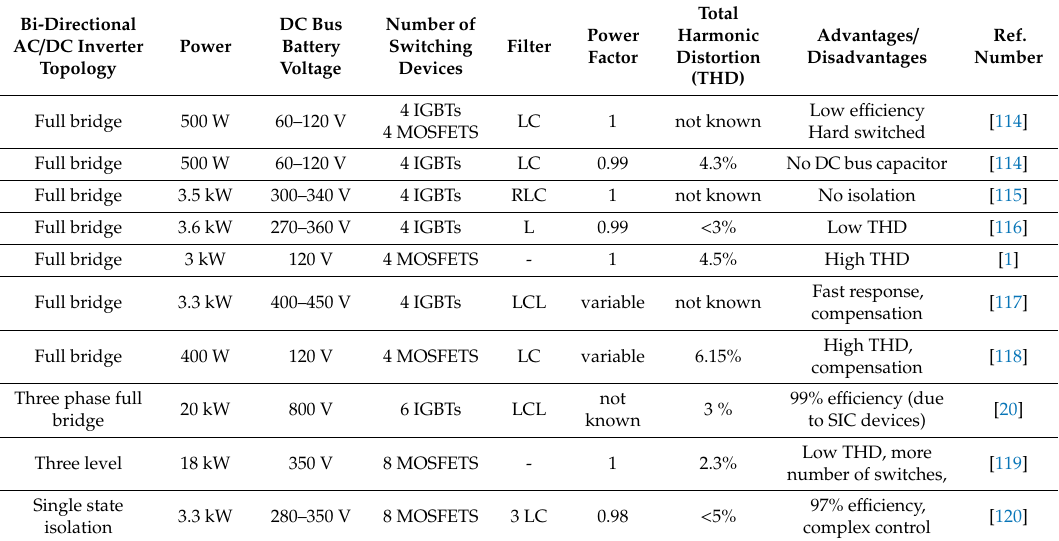
Table 2. Comparison of bi-directional AC / DC inverter topologies for V2G applications in the literature. Bi-Directional AC / DC Inverter